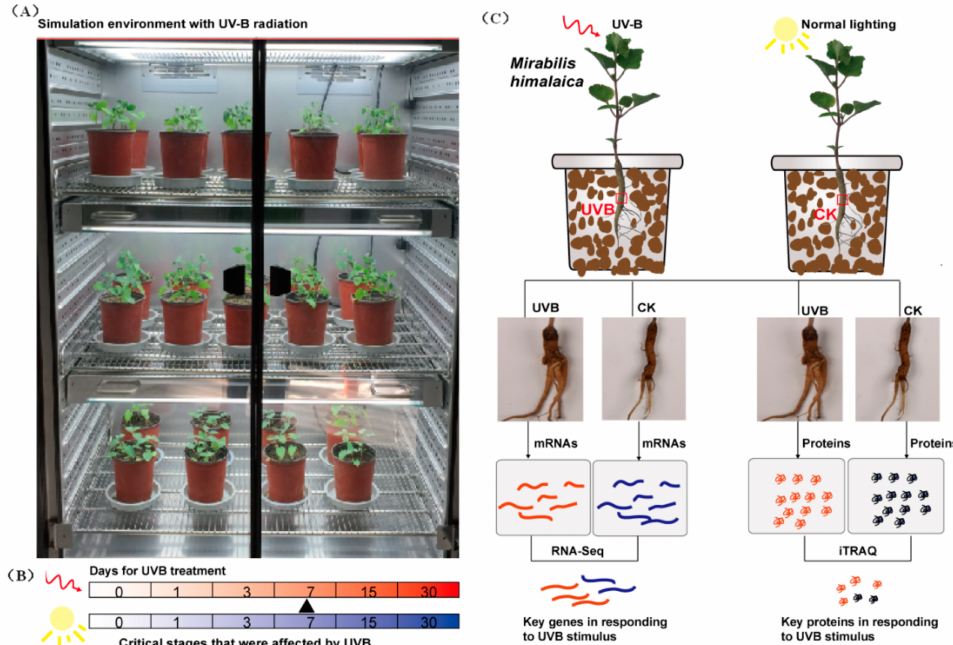
Figure 8. Experimental processing settings and operational procedures. ( A ) Artificial climate chamber used for the experiment; ( B ) Experimental processing settings, the number indicates the days of UV-B radiation; and ( C ) Samples collection and experimental